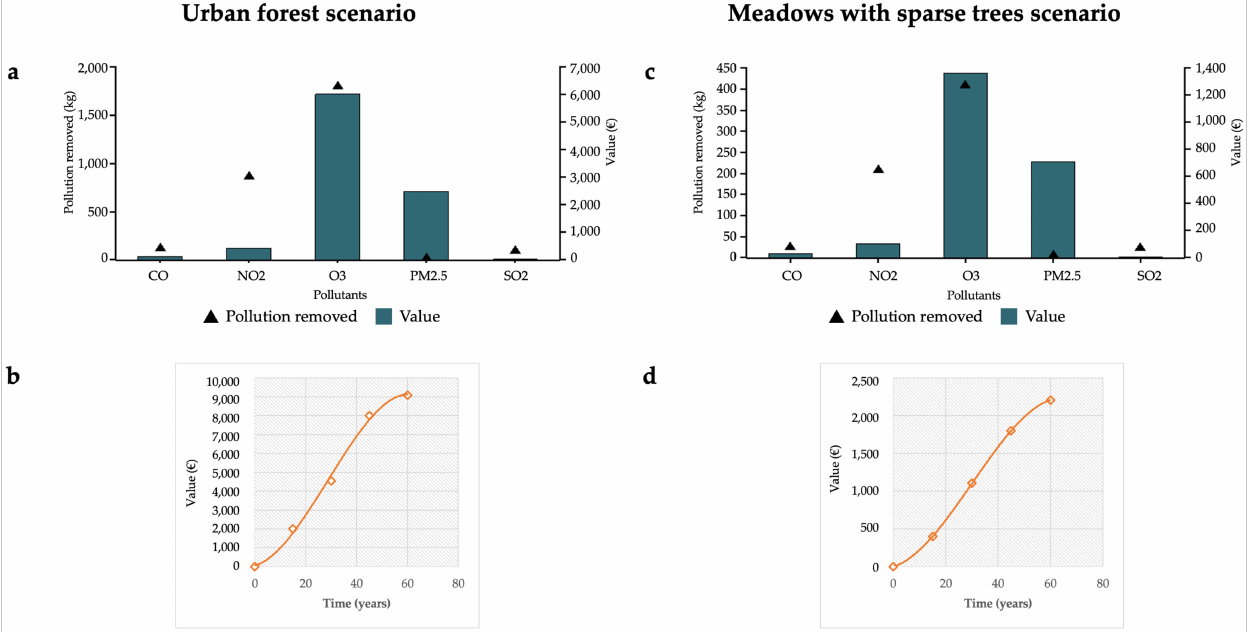
Figure 4. Total pollution removed and economic value of the ES per year and per pollutant ( a , c ), and total value variation over time ( b , d ) under the two intervention scenarios. Please note that the charts use different scales on the vertical